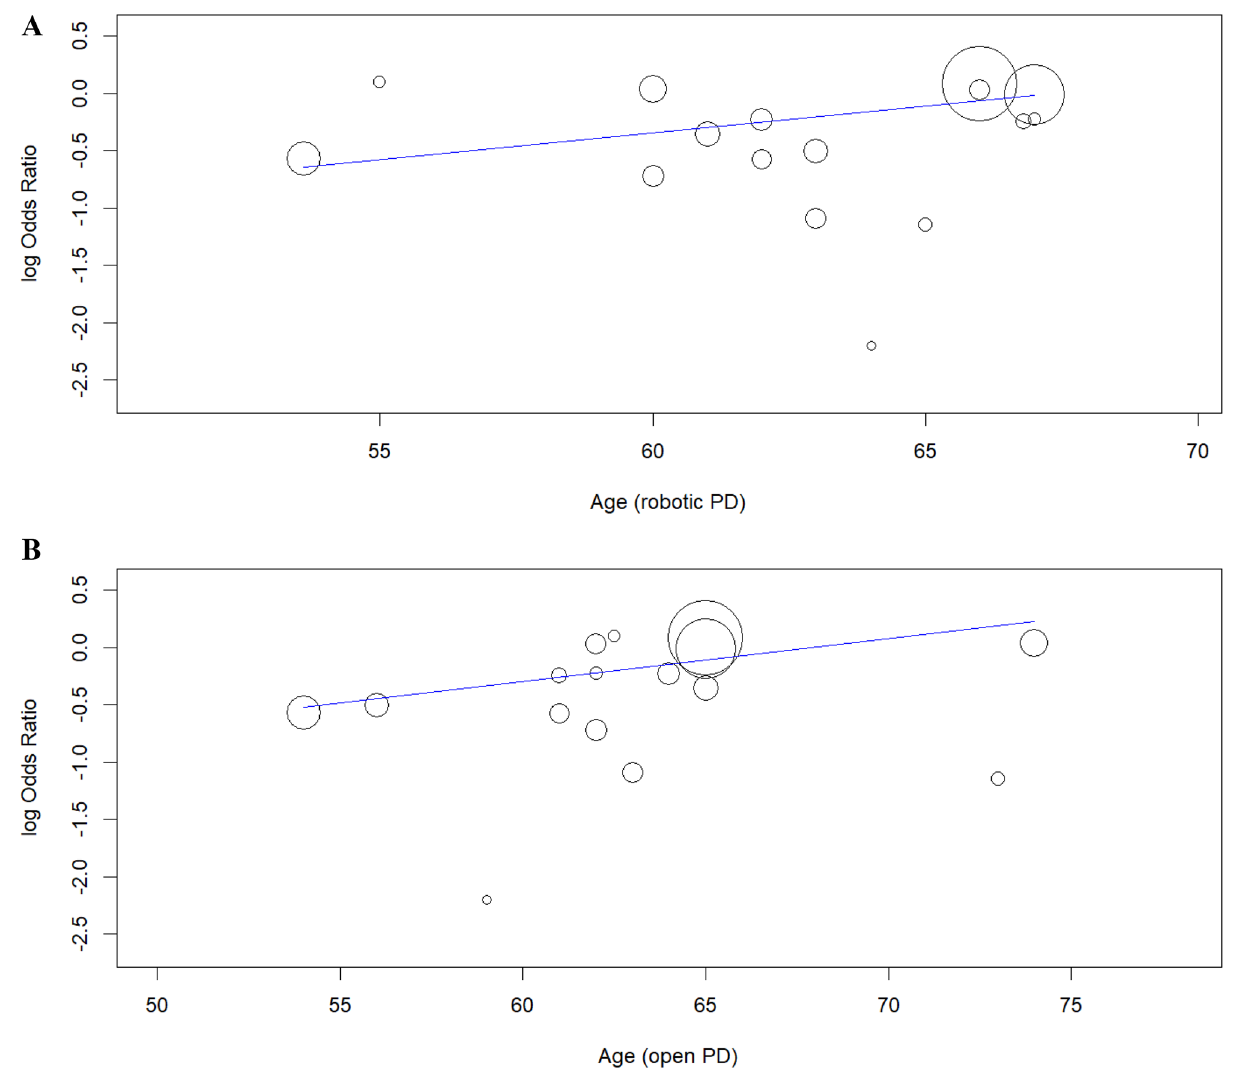
Figure 6. Ad-hoc meta-regression analysis: ( A ) Regression plot of overall postoperative morbidity and average age in robotic PD (Omnibus p = 0.040). ( B ) Regression plot of overall postoperative morbidity and average age in open PD (Omnibus p =